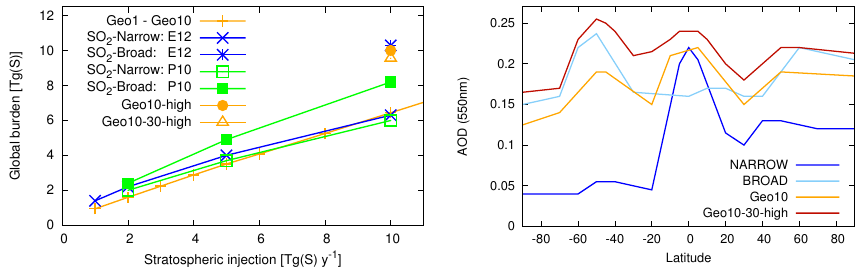
Figure 7. (Left) The global sulfate aerosol burden for ECHAM5-HAM simulations Geo1 to Geo10 compared with results from Pierce et al. (2010), P10, and English et al. (2012), E12, for two different emission areas: SO 2 -NARROW, 5 ◦ N to 5 ◦ S, and SO 2 -BROAD, 30 ◦ N to 30 ◦ S. In the SO 2 -BROAD simulation the injection area is additionally increased vertically to 20–25km. (Right) Plots comparing the zonal mean of the AOD for a narrow and a broad injection area. Plots were created using smoothed values of Geo10 and Geo10-30-high and estimated from “SO 2 NARROW” and “SO 2 BROAD” data after English et al. (2012).